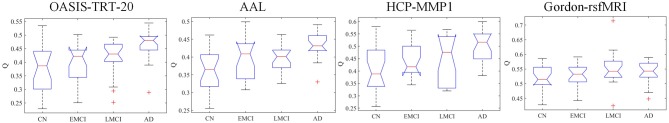
Group median and interquartile ranges of Q coefficient of modularity structure for each group. P-values derived from Kruskal-Wallis tests assessing SC topological differences among NC, EMCI, LMCI, and AD for each parcellation scheme are reported in Table 5.